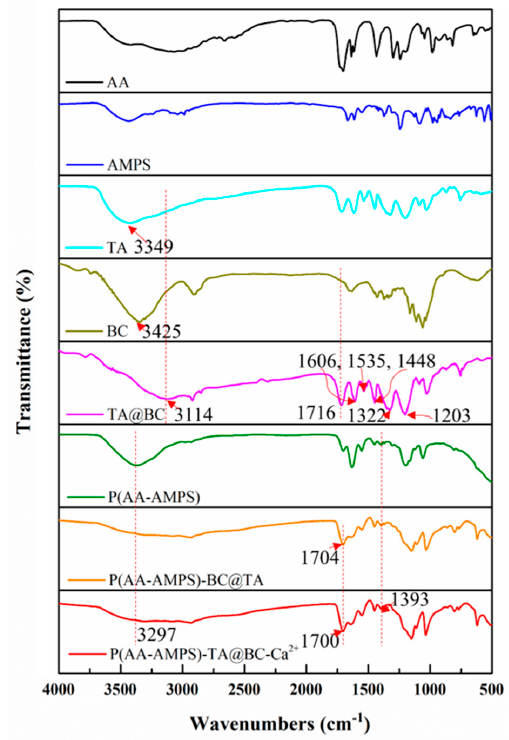
Figure 2. The FT-IR spectra of AA, AMPS, TA, BC, TA@BC, P(AA-AMPS), P(AA-AMPS)-TA@BC, Figure 2. The FT ‐ IR spectra of AA, AMPS, TA, BC, TA@BC, P(AA ‐ AMPS), P(AA ‐ AMPS) ‐ TA@BC, and and P(AA ‐ AMPS) ‐ TA@BC.